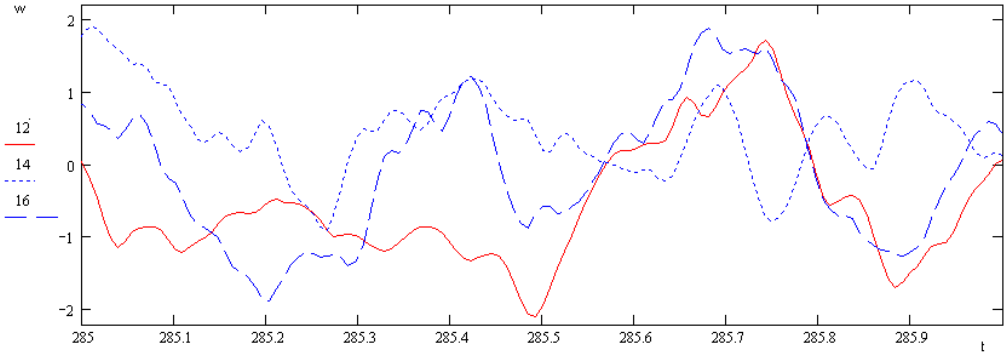
Fig. 2. Deflection ( ) w t versus n in a chaotic zone.